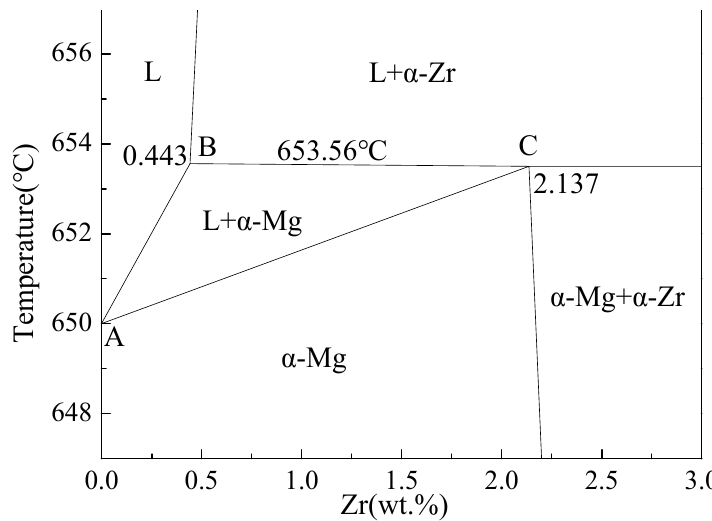
was significantly shortened. At that time, a large number of Zr particles precipitated before the peritectic temperature, and their number also gradually increased with the increment of Zr content. In other words, the more Zr particles precipitated, the more conducive they were to the rapid solidification of the Mg-Zr melt and the formation of a fine solidification structure, from which we could infer that the first precipitated Zr could become an effective heterogeneous nucleus of α –Mg. Therefore, only from the phase diagram, we could confirm that the heterogeneous nucleation effect of Zr precipitated first.